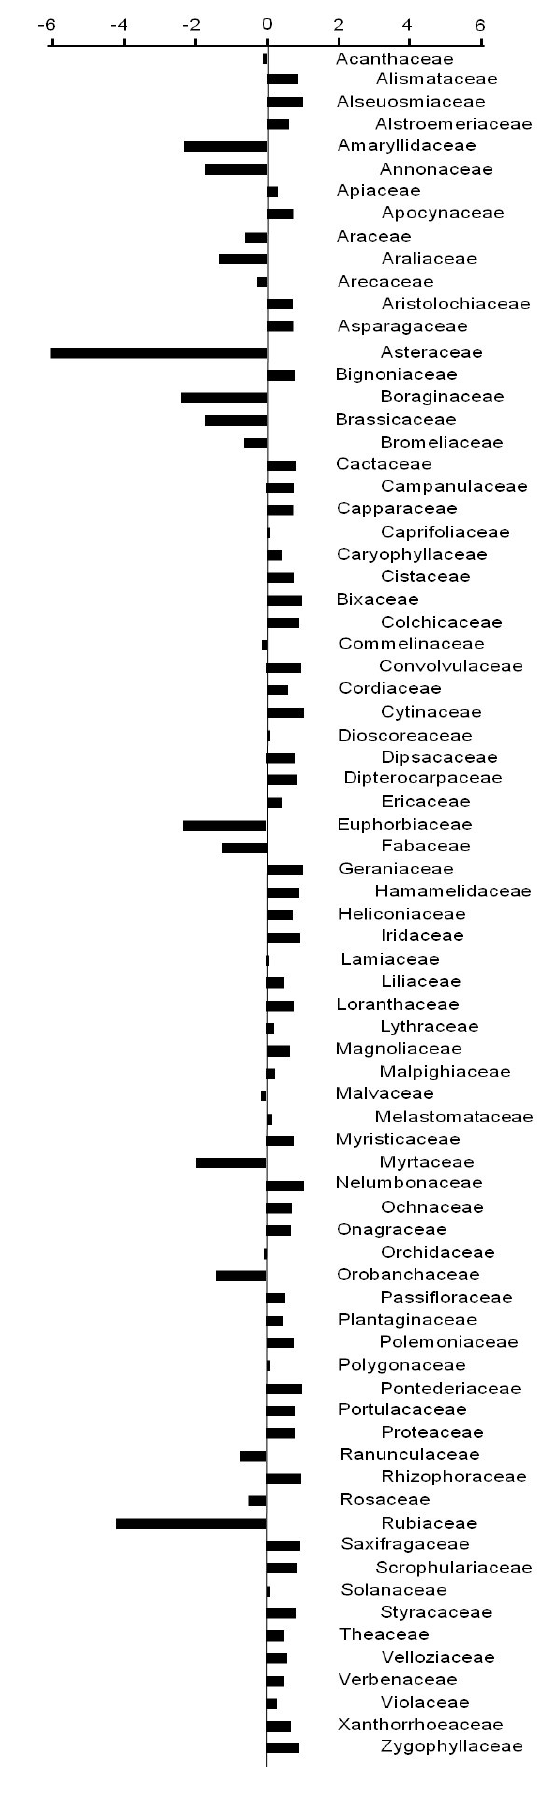
families in the R-G analysis. The bars show 1 – [(proportional representation in R-G)/(proportional representation among all angiosperm species)] for each family. A value of zero indicates that the family is sampled in relation to its size, a negative value that it is under-represented in R-G, and a positive value that it is over-